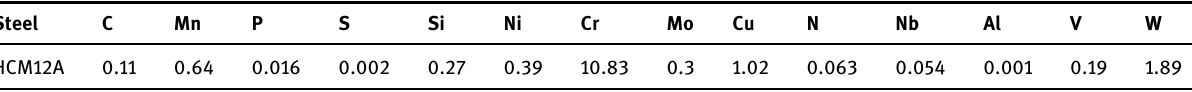
Table 1: Chemical compositions of HCM12A steel ( wt% )